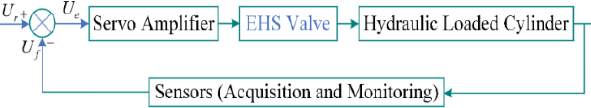
Figure 3. Block diagram of the hydraulic control system.